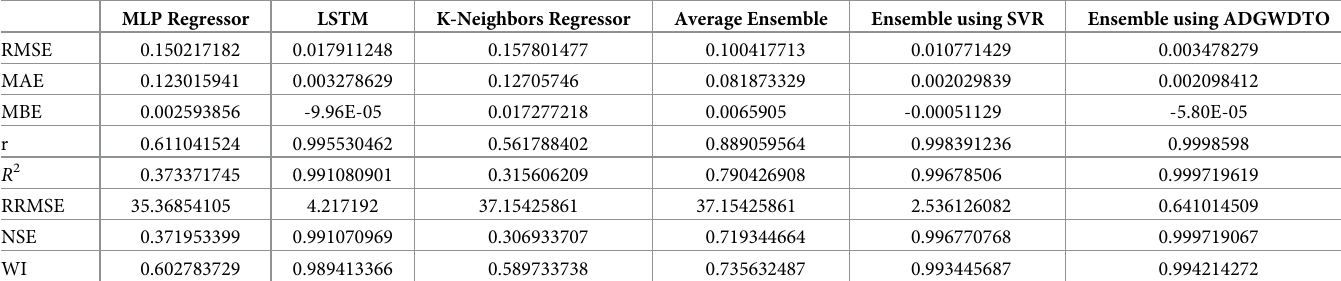
Table 7. Performance of the proposed weighted optimized ensemble model compared to state-of-the-art algorithms. MLP Regressor